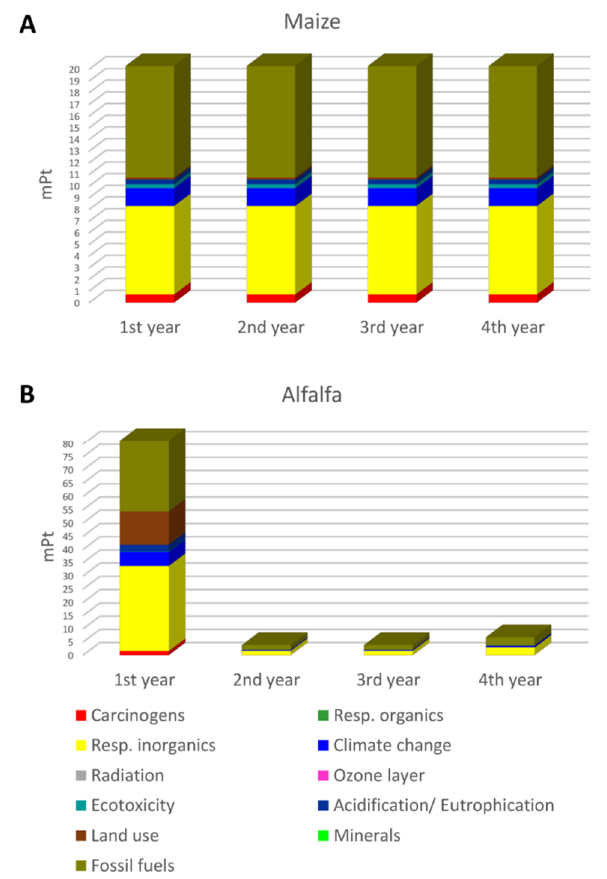
Figure 2. Comparison of maize’s ( A ) and alfalfa ( B ) impacts in milli-Points (mPt) in a useful life of 4 years.